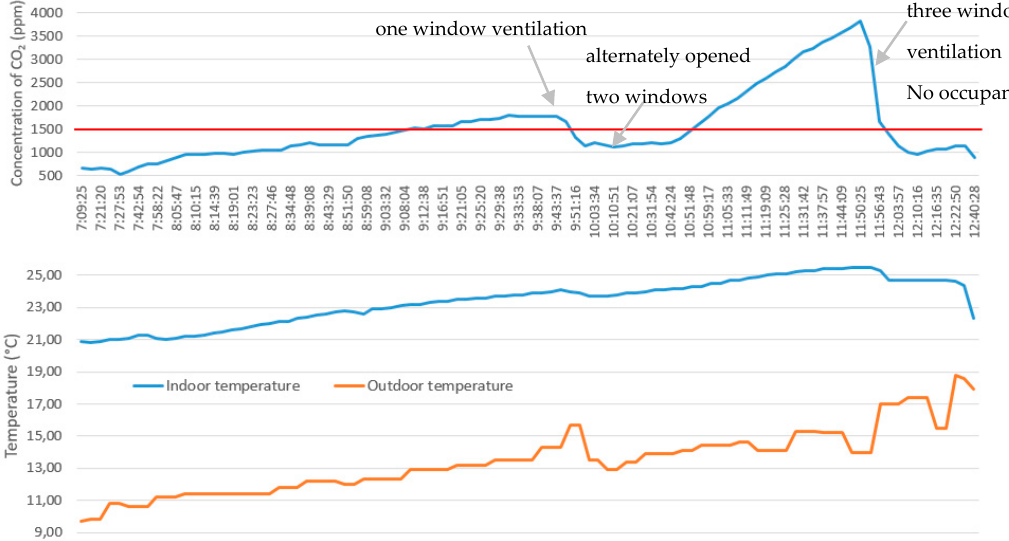
Figure 5. Dependence of CO 2 emissions on the classroom’s ventilation (window opening) and indoor and outdoor temperatures.